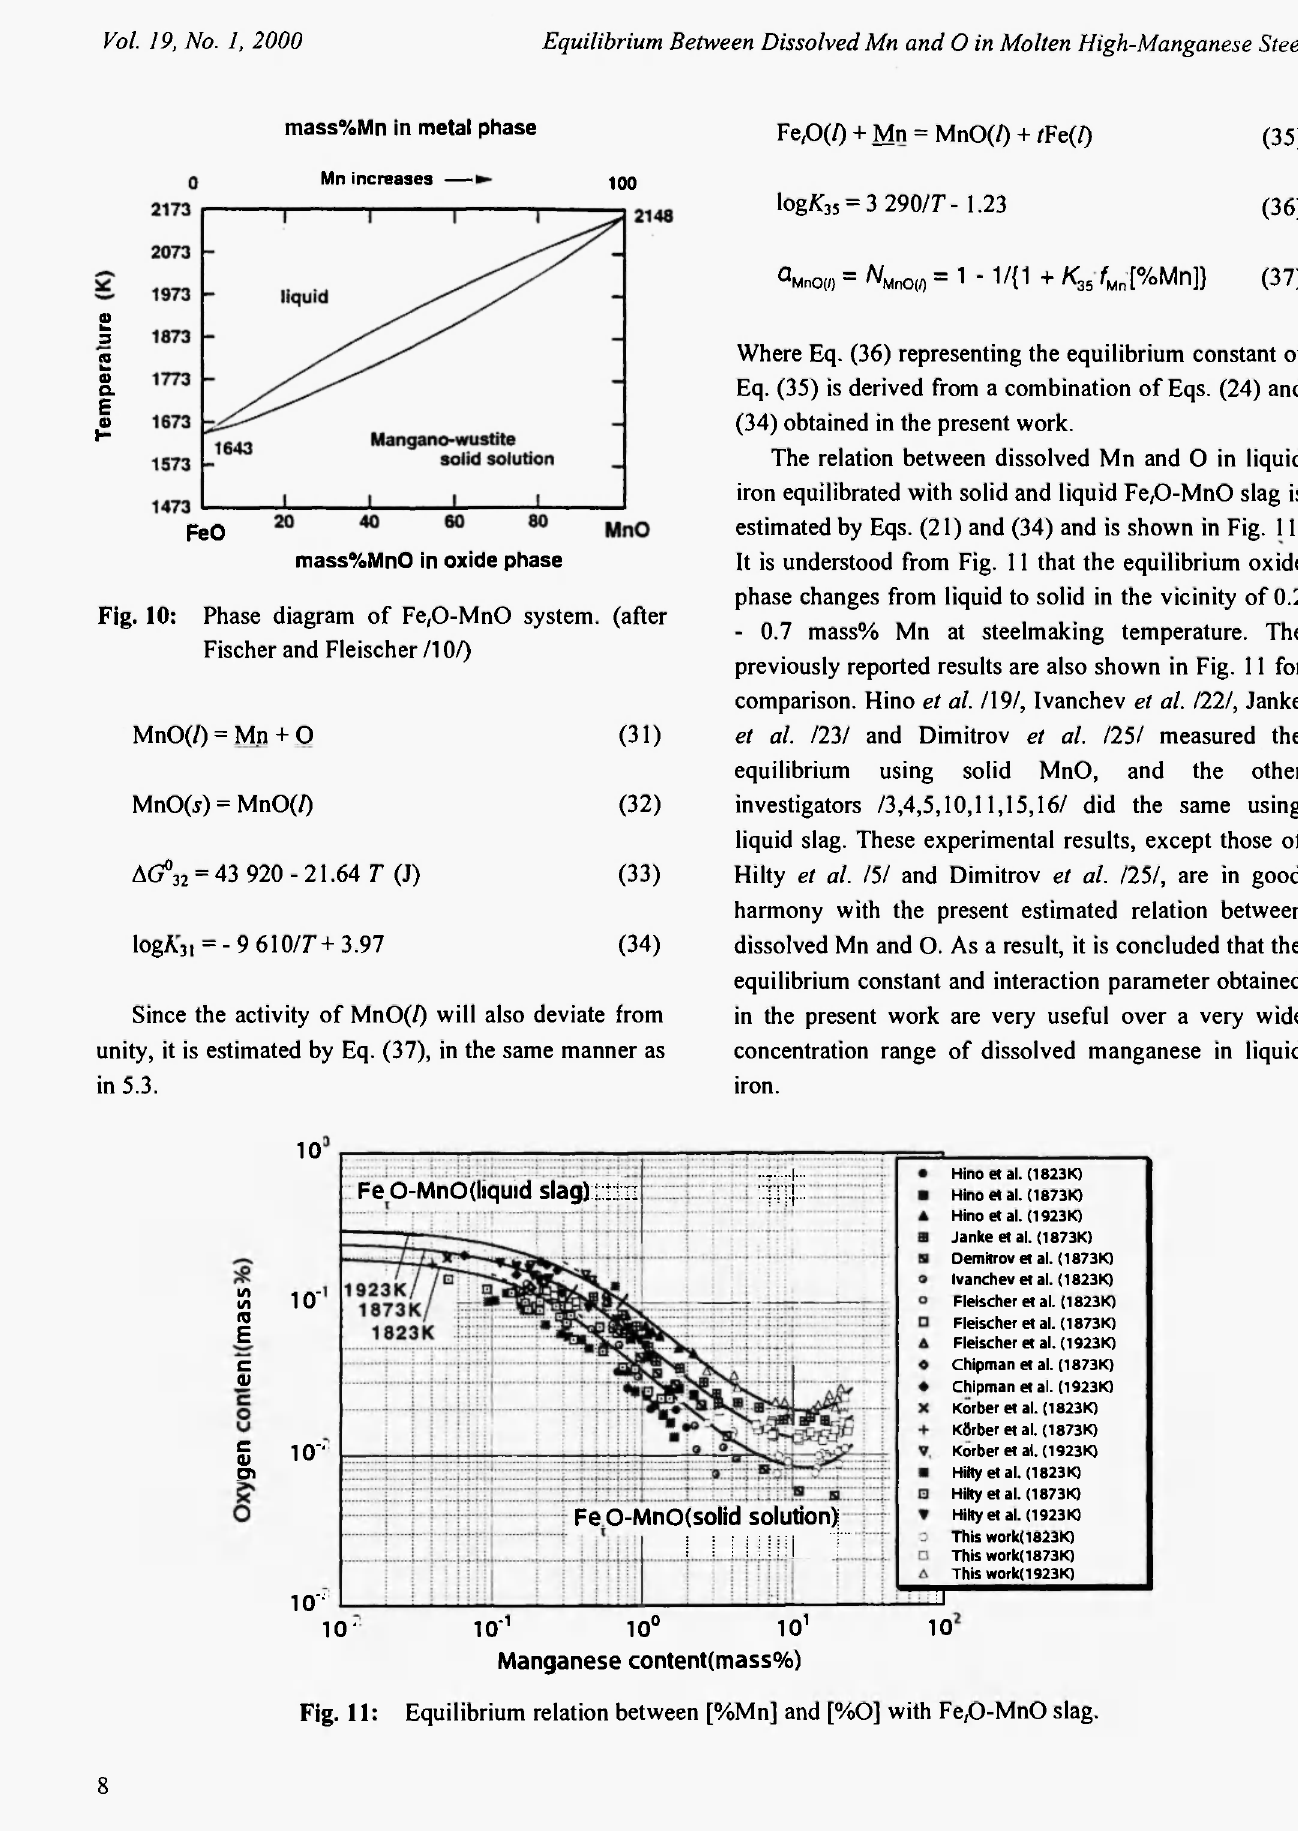
Fig. 10: Phase diagram of Fe,0-Mn0 system, (after Fischer and Fleischer /10Γ)